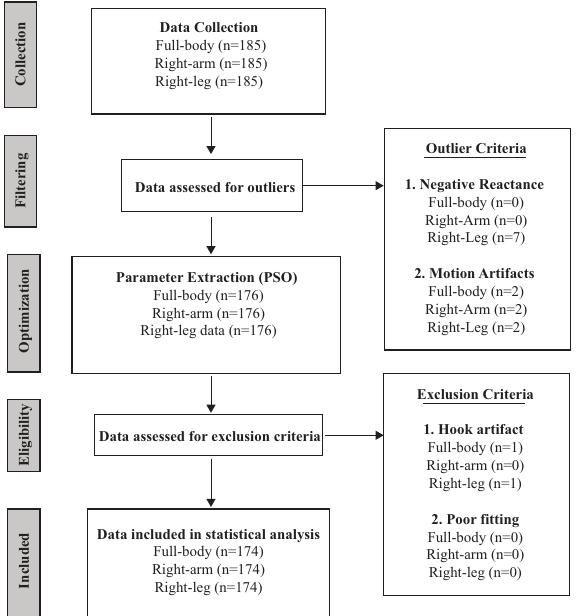
Figure 4. Process applied to complete set of electrical impedance datasets for outlier identifica- tion/removal, resulting in the use of N = 174 participant datasets (from an original set of N =